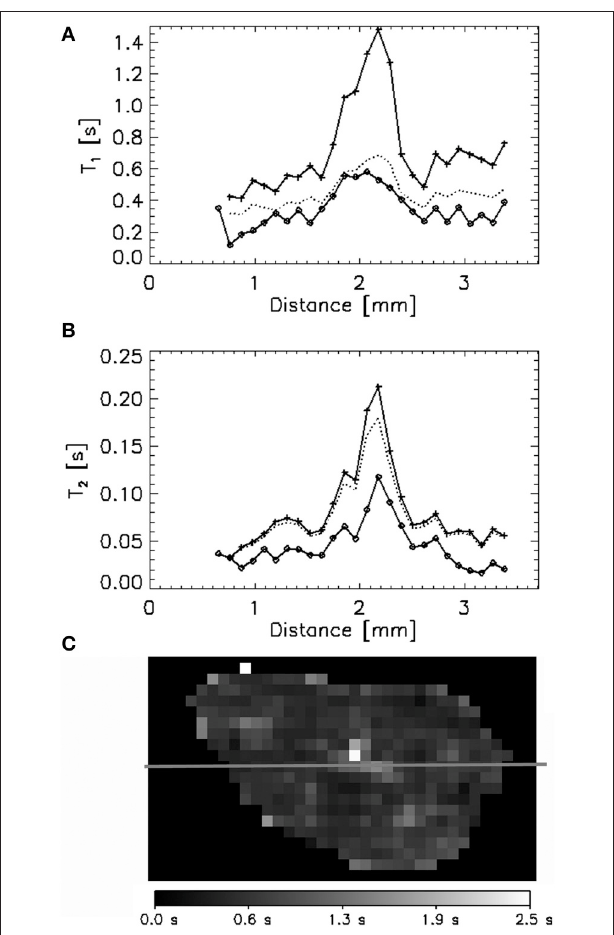
FIGURE 7 | A single T 1 (A) and T 2 (B) profile through a single granule illustrated by the red line in a 2D T 1 map (C) comparing the initial values ( + ), the values after exposure to 5mmol · L − 1 CoCl 2 solution ( ♦ ) and the values calculated assuming that the T 1 and T 2 decrease was caused only by the presence of Co in the liquid